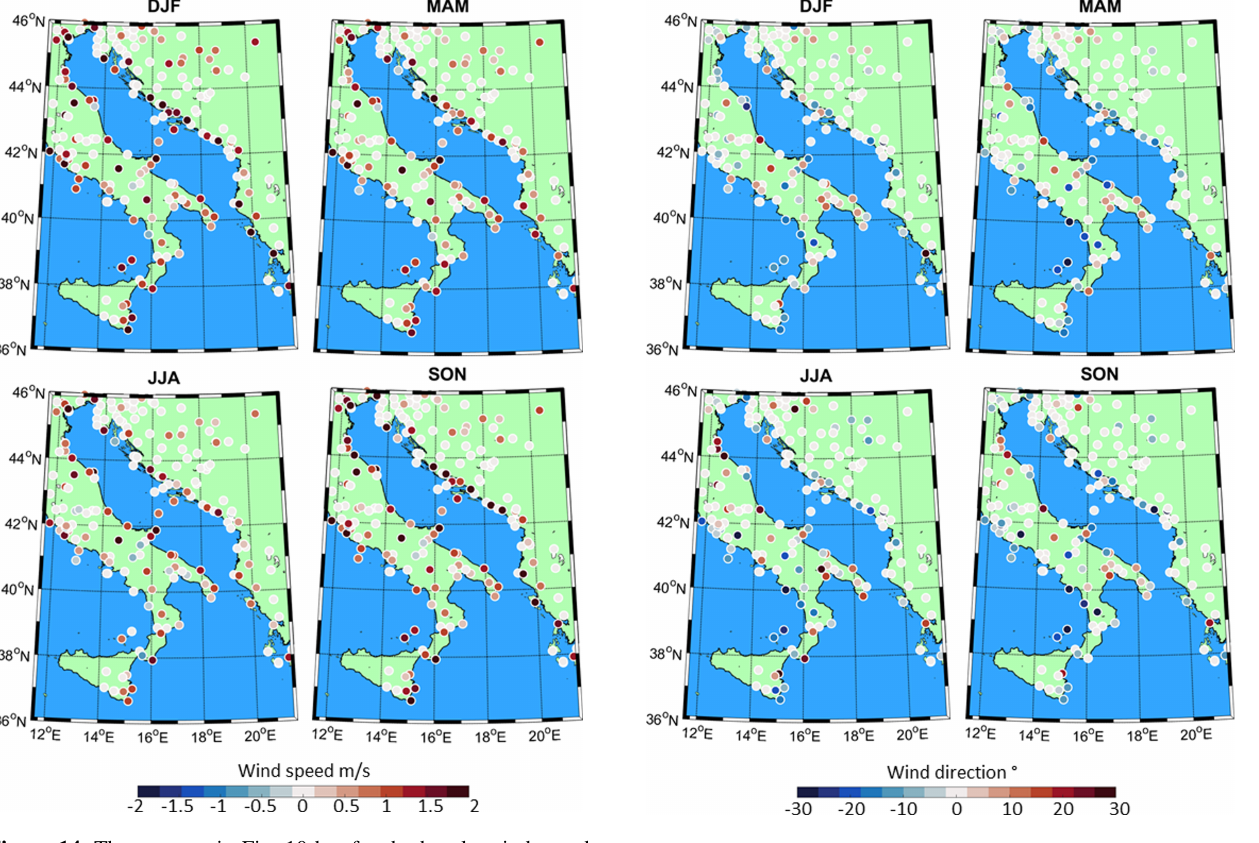
Figure 15. The same as in Fig. 10 but for the hourly wind direction bias (i.e. shift in direction, positive